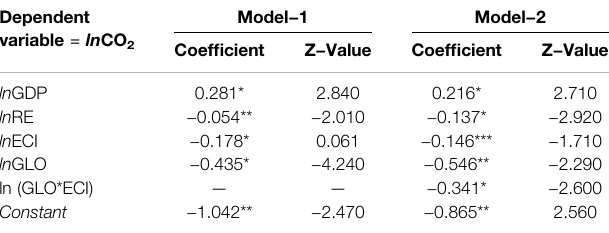
TABLE 7 | Robustness test